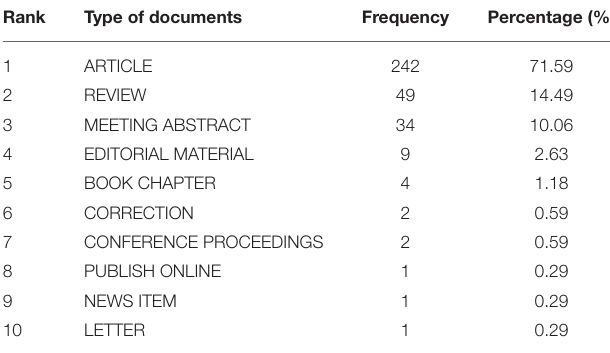
TABLE 1 | The number of different types of articles in the NMU research from 1987 to